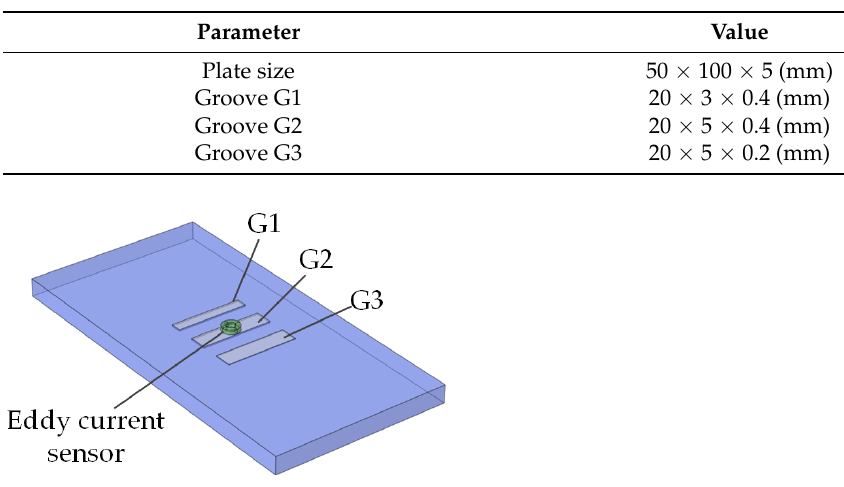
Table 1. Details of the simulation model.